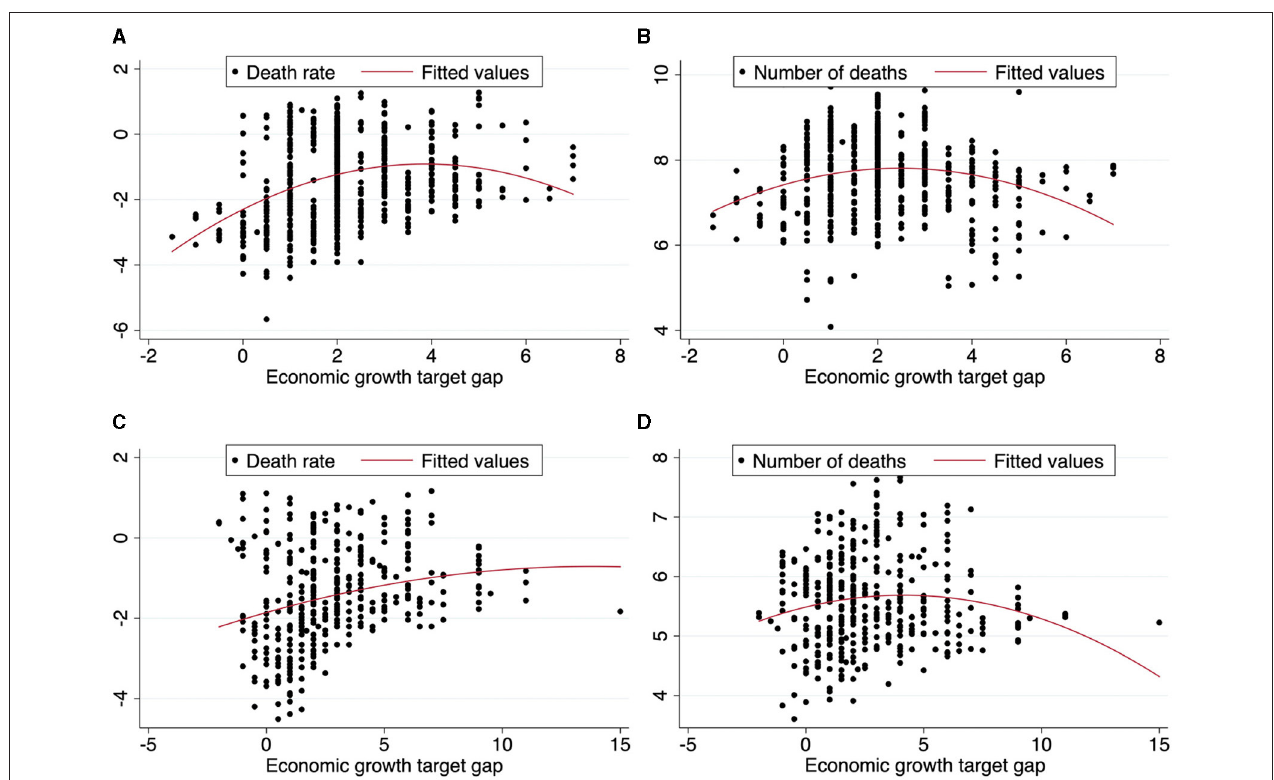
FIGURE 2 | The scatter diagram of the relationship between economic growth target gap and the quality of public occupational health. (A) Economic growth target gap and death rate at provincial level. (B) Economic growth target gap and number of deaths at provincial level. (C) Economic growth target gap and death rate at city level. (D) Economic growth target gap and number of deaths at city